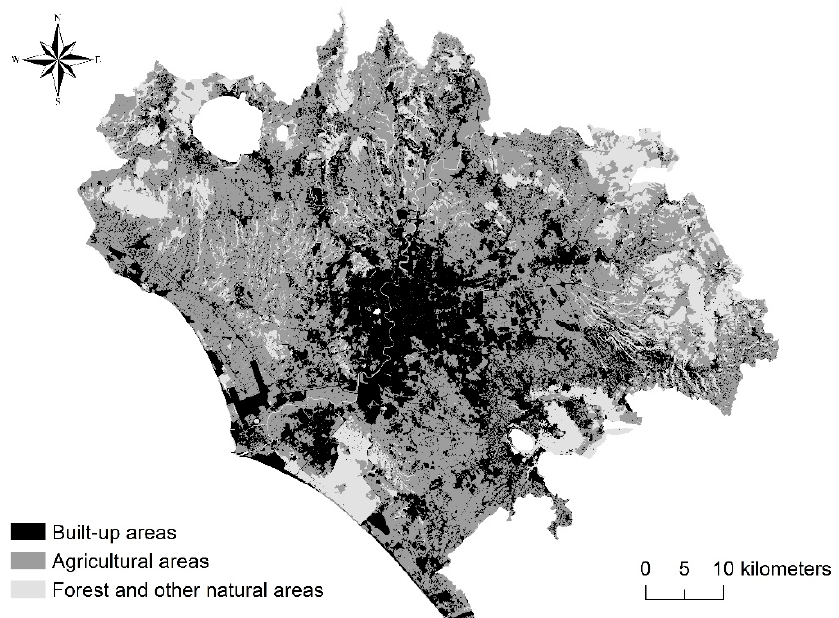
Figure 1. Spatial distribution of selected land use classes in the functional area of Rome, Central Italy (source: Urban Atlas GMES Land Copernicus initiative) .